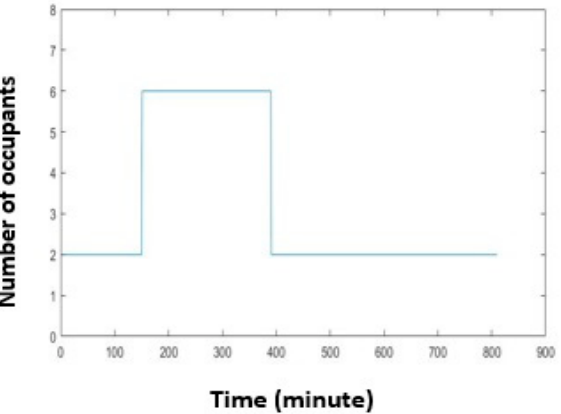
Figure 17. Occupancy versus time during the experiment in an office room with a small size.